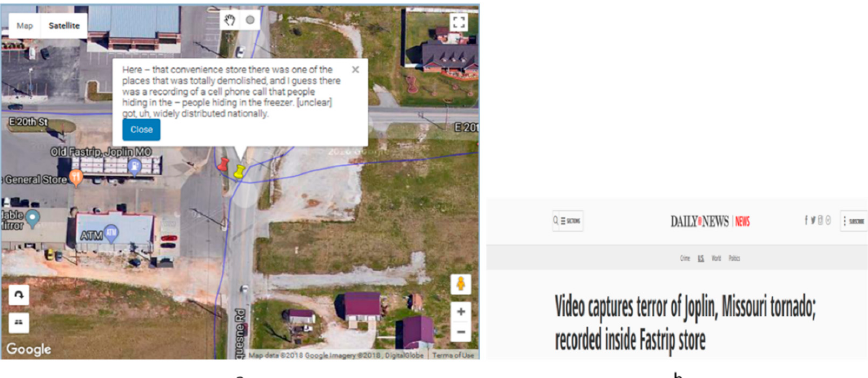
Figure 7. Wordmapper visualization module showing the ( a ) narrative sentence for the keyword ‘recover*’ and ( b ) response by the interviewee about recovery without using the word ‘recover’. The